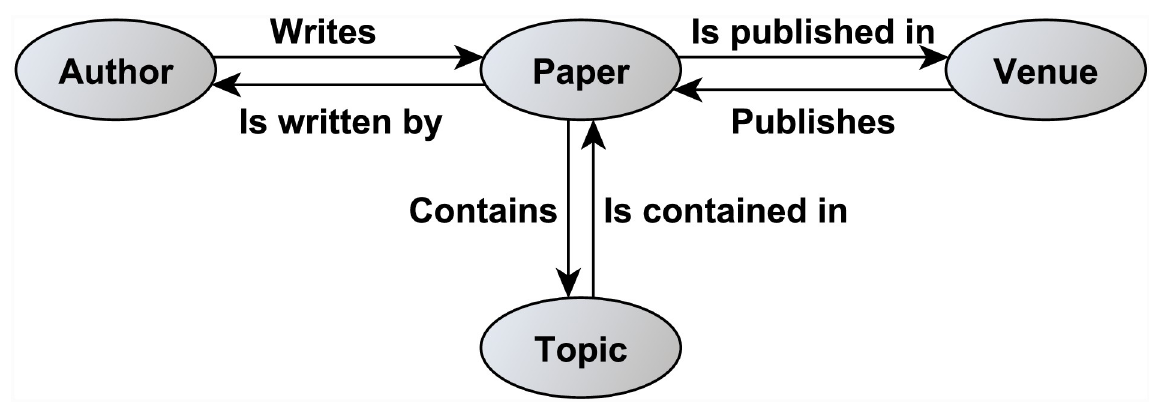
Fig 1. DBLP network